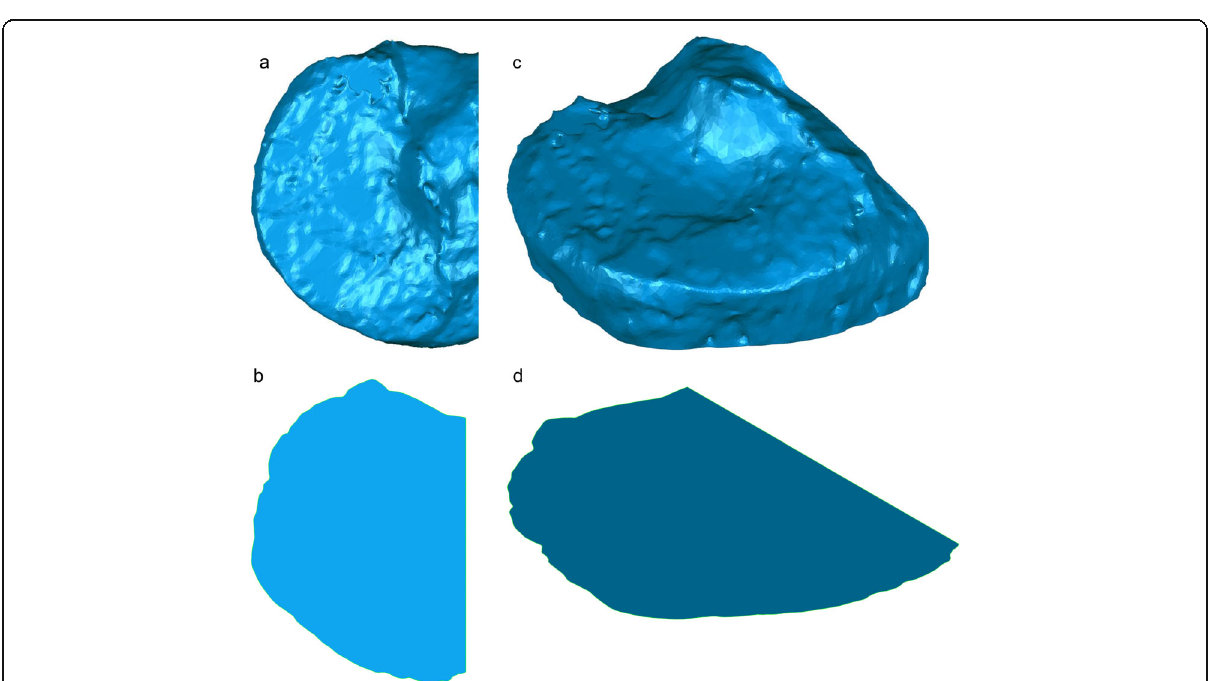
Fig. 3 Cross-sectional model of the medial tibial plateau. Cross-sectional model is a cross section of the medial tibial plateau model at the level of 10.0 mm inferior to the origin parallel to the ZX plane. a Axial view of the medial tibial plateau model. b Axial view of the cross-sectional model of the medial tibial plateau. c Anteromedial view of the medial tibial plateau model. d Anteromedial view of the cross-sectional model of the medial tibial plateau